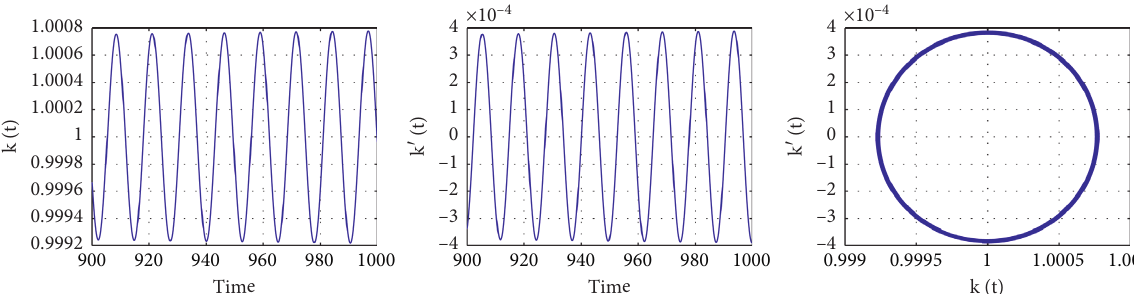
Figure 6: The birth of Hopf-bifurcated limit cycle from the fixed point k ∗ for the studied case when q � 1.